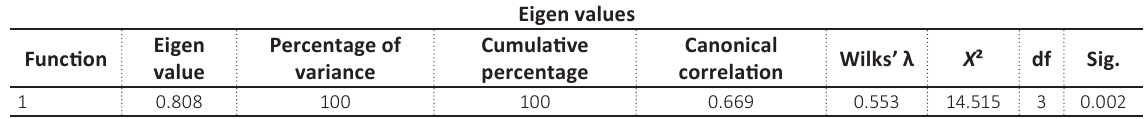
Table 8. Outline of canonical discriminant functions ( t